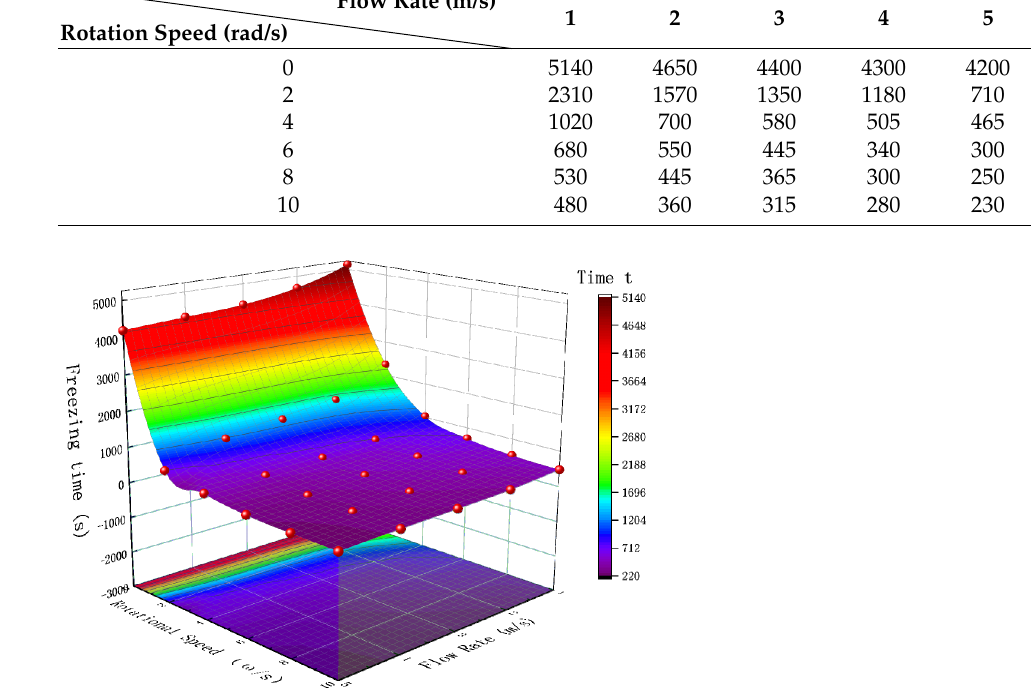
Figure 17. Curved surface diagram of time taken for the center of the pork to reach − 18 °C with changing flow rate and rotational speed.